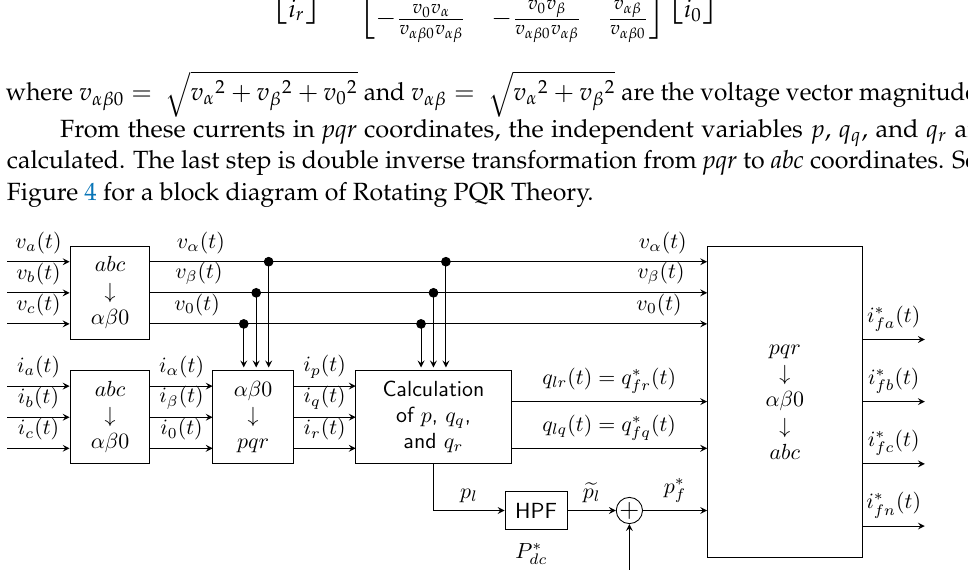
Figure 4. Block diagram of Rotating PQR